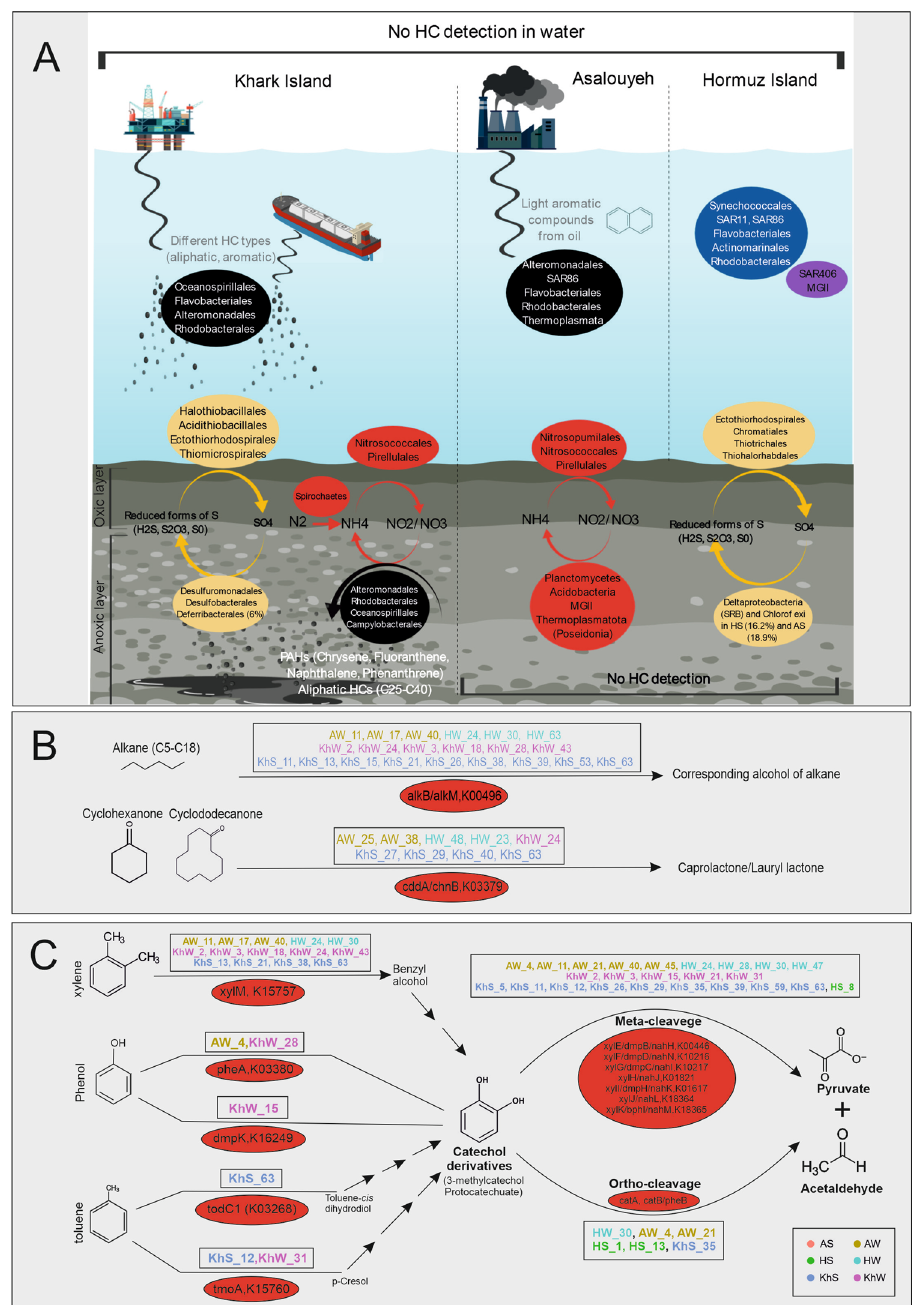
Figure 7. The microbial community dynamics of the Persian Gulf water and sediment samples in response to oil pollution and their degradation potential. ( A ) Overview based on16S rDNA abundance. Hormuz Island was considered as a control location with the least impact from oil pollution. Taxa written in the blue frame are prevalent marine representatives present in HW. Microbial taxa in the Purple frame are mainly detected in OMZ areas and are also present in HW. Samples collected from Asalouyeh province are exposed to potential pollution caused by Gas field wastes. High oil trafficking, oil exploration and extraction, and natural oil seepage are the primary potential pollution sources in Khark Island. The possible pollutant types are shown in gray; however, the hydrocarbon pollution was below the detection limit in collected water samples. Black circles represent microorganisms that are involved in HC degradation in water samples from Asalouyeh and Khark Island. Microbes involved in sulfur and nitrogen cycle are shown in yellow and Red circles, respectively. HS and AS had similar silt and sand-sized sediments with HC below the detection limit. KhS had gravel-sized particles and showed the highest oil pollution shown in white. ( B ) MAGs containing key enzymes for degradation of aliphatic and cycloalkane compounds under aerobic conditions. ( C ) MAGs containing key enzymes for degradation of aromatic compounds under aerobic conditions. PG MAGs did not have Key enzymes for hydrocarbon degradation under anaerobic conditions therefore, it is not shown. Red circles in B and C panels represent key enzymes involved in the degradation. The name of MAGs containing mentioned enzymes are written in rectangles. The MAGs are colored based on the samples they have been recovered from and the legend is shown in the lower right corner. Figure has been created with